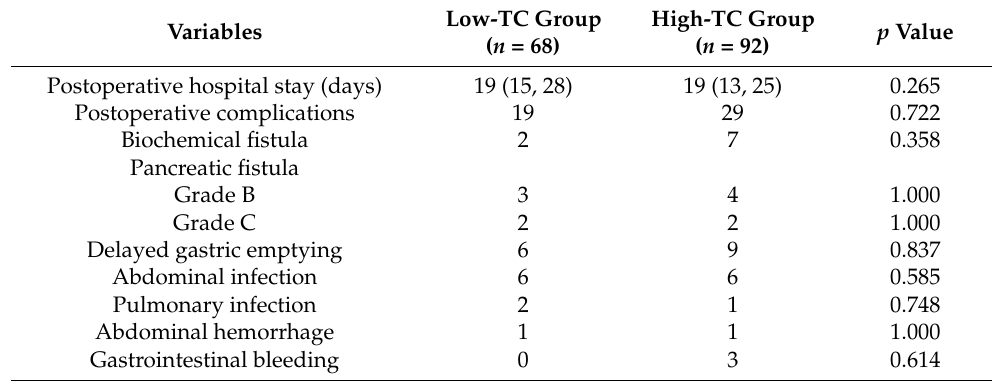
Table 4. Comparison of major postoperative complications between low-TC group and high-TC